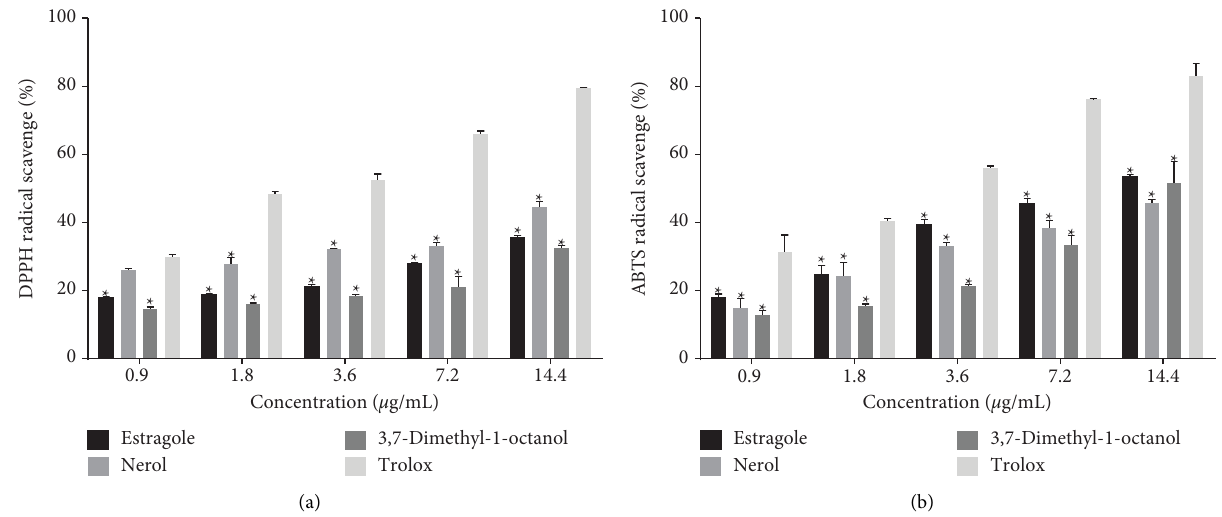
Figure 3: Efects of nerol, estragole, 3,7-dimethyl-1-octanol and Trolox on the inhibition of DPPH (a) and ABTS (b) radicals. Notes: Values are mean ± SD of triplicate value. ∗ p < 0 . 05 vs. trolox (ANOVA followed by t -Studentpost-hocNeuman-Keuls test). NC showed negligible DPPH (1.23 ± 0.58) and ABTS (1.08 ± 0.23) radical scavenging capacity, therefore, the values have not been shown in the fgures.